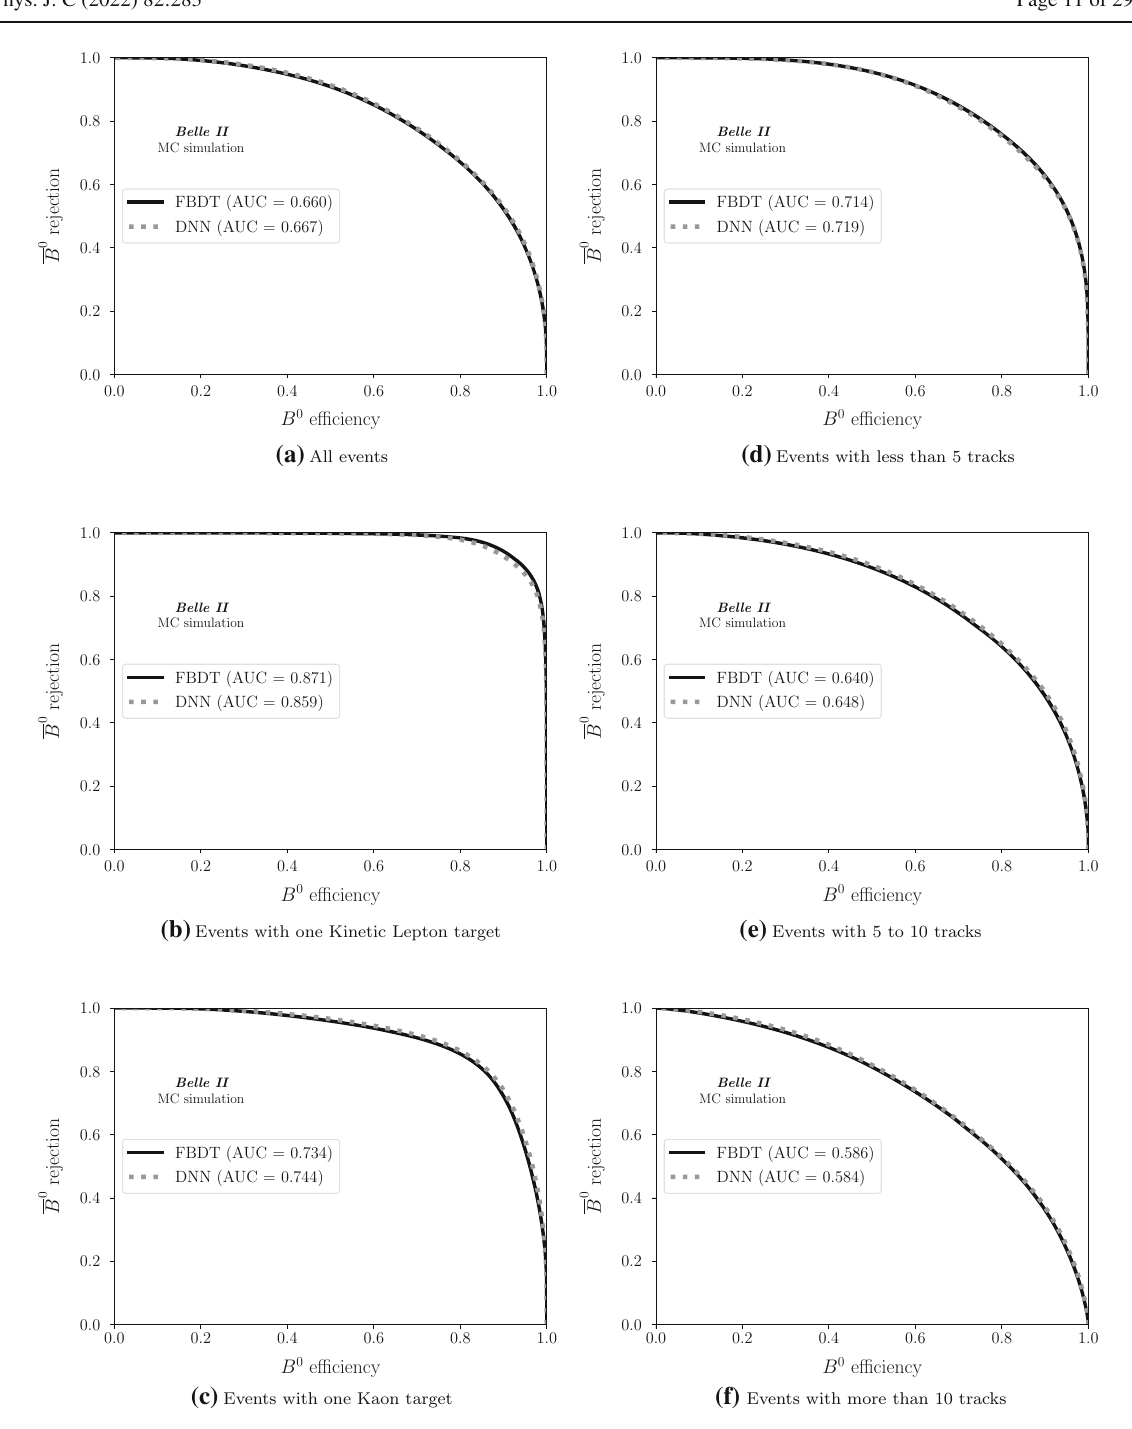
Fig. 5 Receiver operating characteristic curves comparing the per- formance of the DNN tagger and the category-based (FBDT) tag- ger in the testing B 0 → ν τ ν τ simulation sample. Curves and val- ues of area under the curve (AUC) are shown for (left) all events,